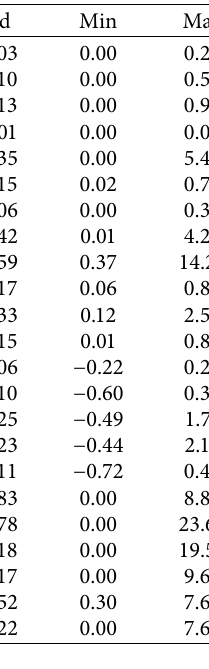
Table 2: Judgment matrix comparison